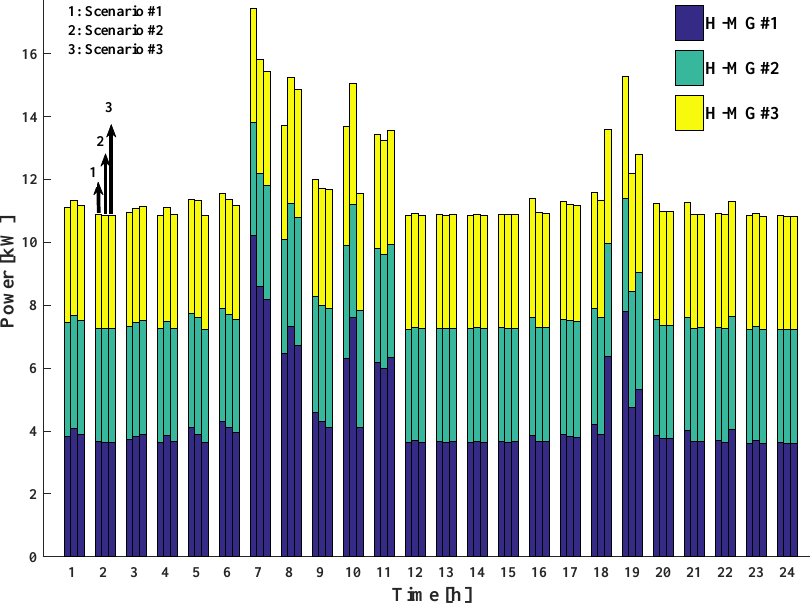
Figure 8. DGU power profile of each